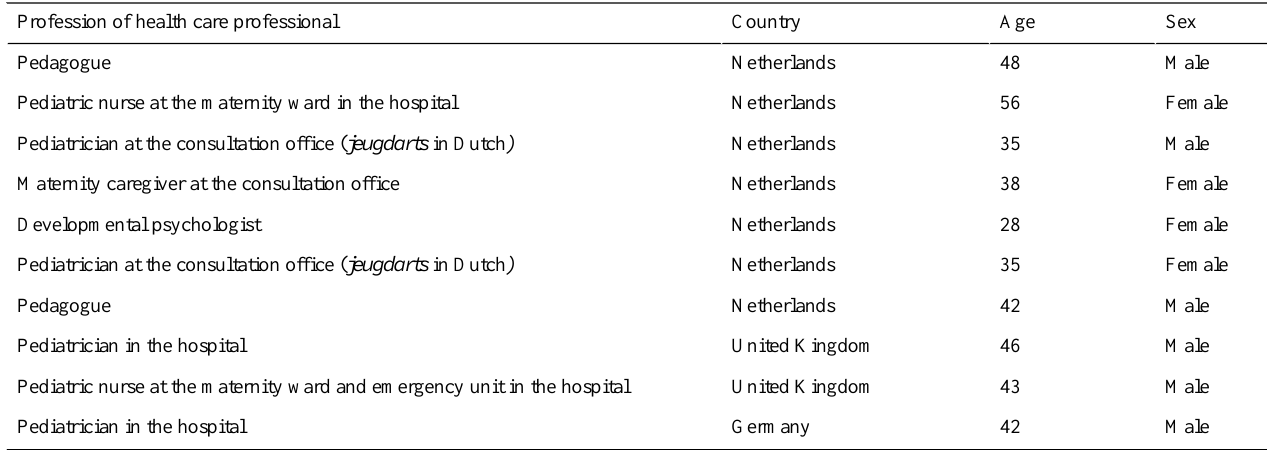
Table 1. Participants’background and